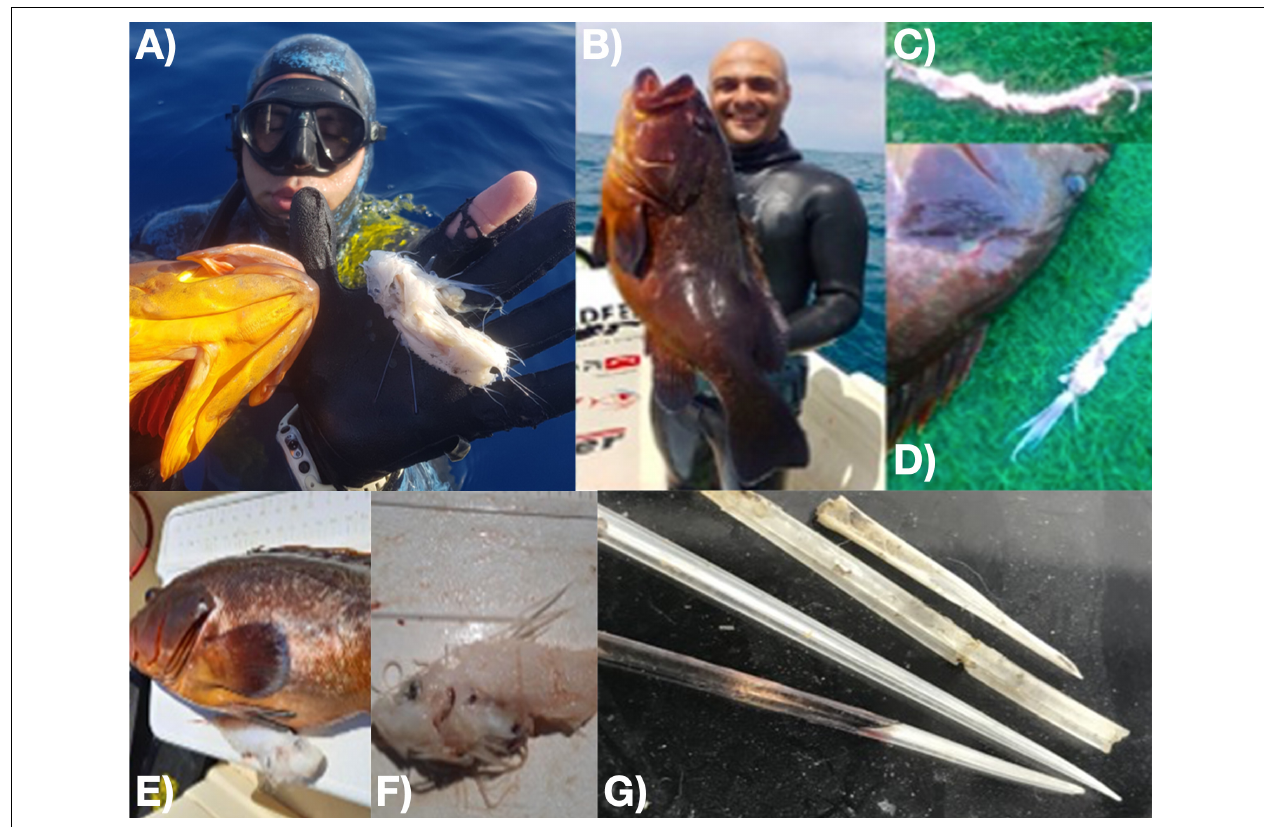
FIGURE 3 | Photographs evidencing predation on invasive Pterois miles in the Mediterranean (details in Table 2 ): (A) Epinephelus aeneus ; (B–D) Epinephelus marginatus ; (E) Epinephelus marginatus , with (F) regurgitated P. miles body; and (G) spines found inside L. sceleratus (top two spines) compared to P. miles dorsal spines (bottom two spines), both sets having the same tri-lobed